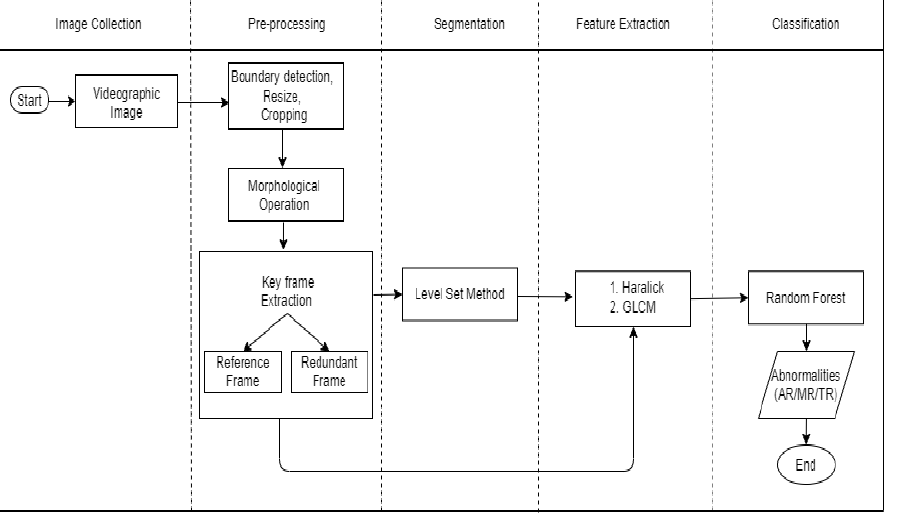
Figure 3. Flowchart of proposed